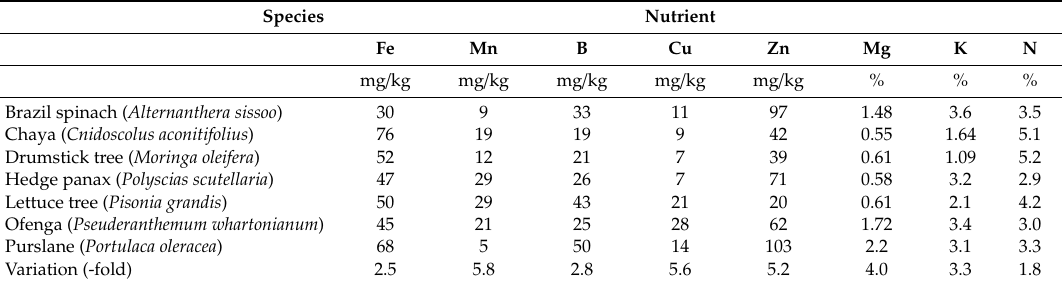
Table 1. Concentrations of macro- and micronutrients in leaves (dry weight basis) of di ff erent food plant species grown together on the same soil type at Vaiaku, Funafuti, Tuvalu in August 2014.